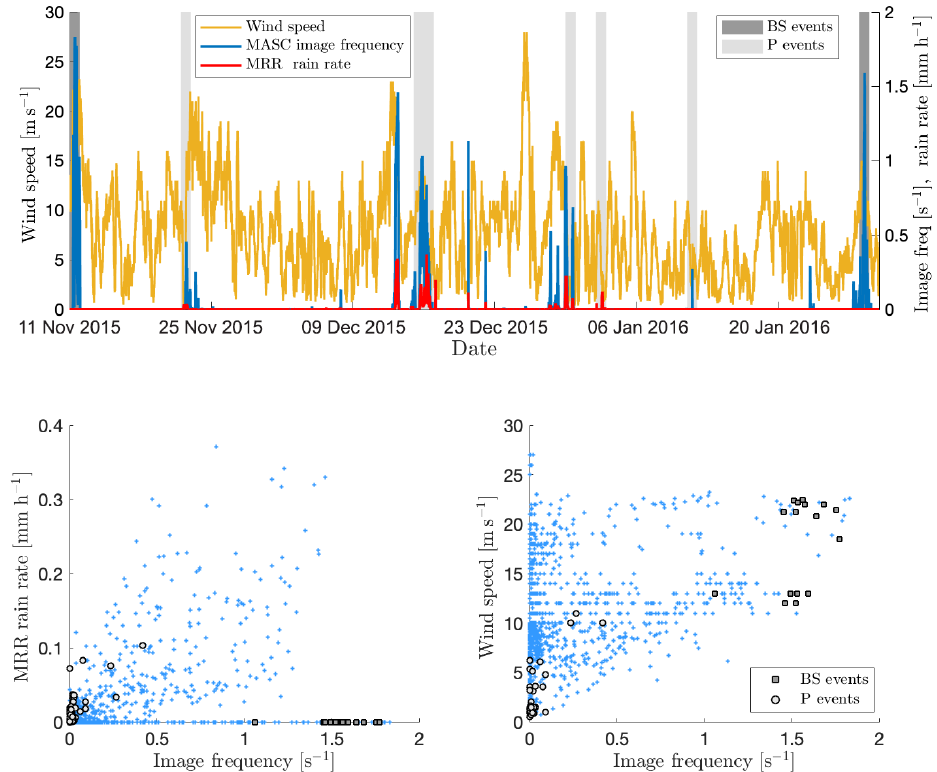
Figure 3. Time series and scatter plots of MASC image frequency, wind speed (measured at 10m) and MRR-derived rain rate for the Antarctica 2015–2016 campaign. The gray shading indicates days during which time steps have been selected for the training set as blowing snow (dark gray) or precipitation (light gray). In the bottom scatter plots, the markers figure the selected blowing snow and precipitation time steps. Points on the x axis in the left scatter plot are potential candidates for pure blowing